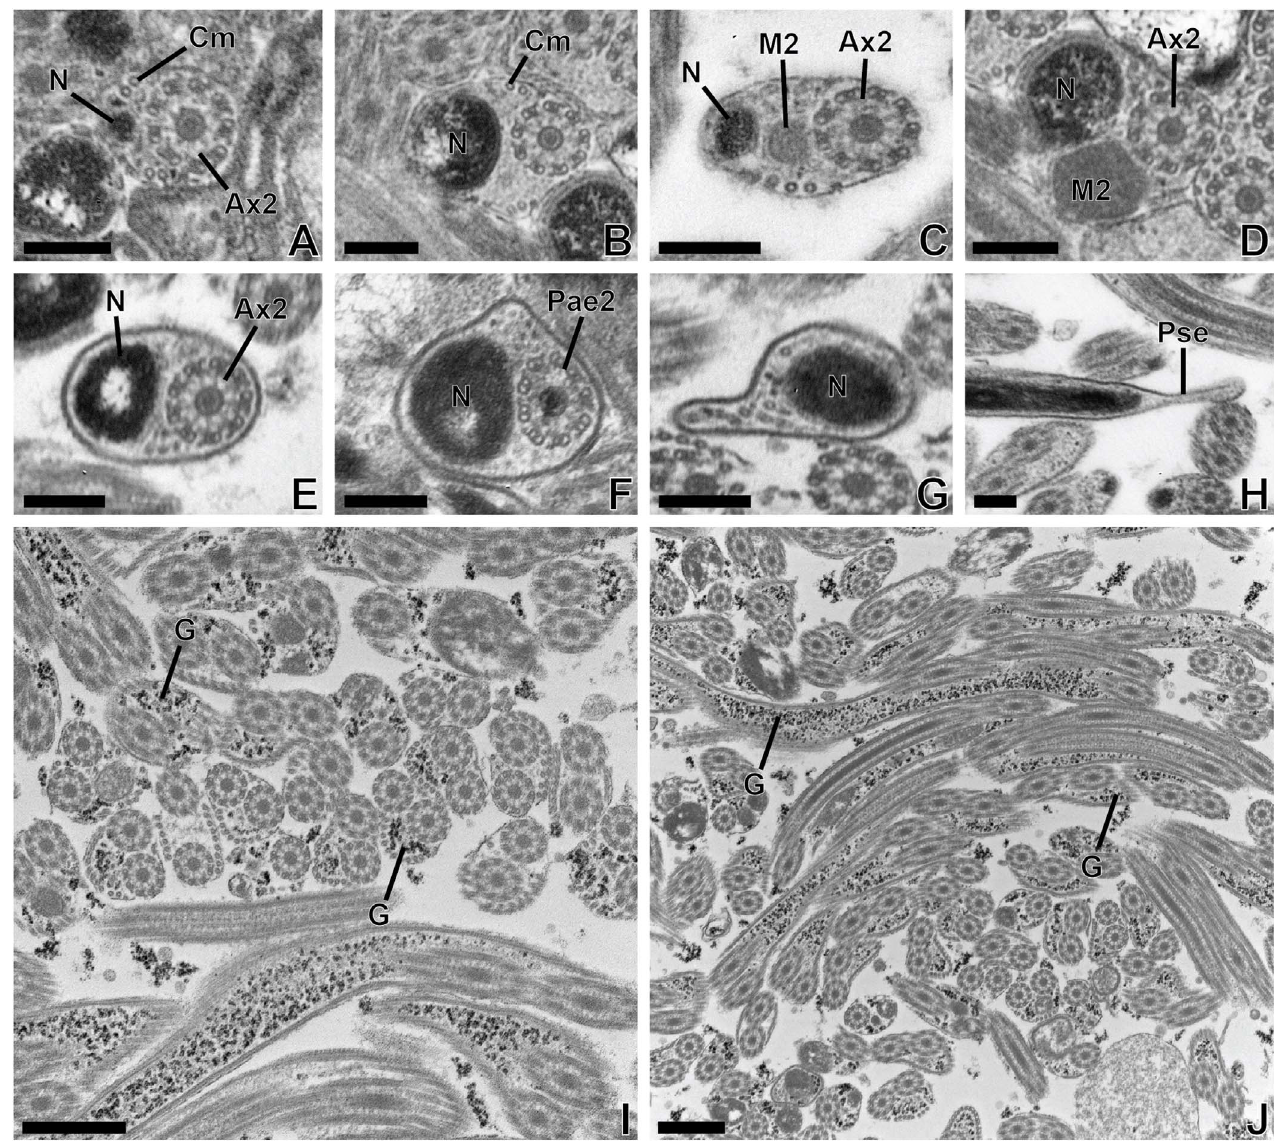
Figure 4. (A – H) Transmission electron micrographs of the posterior region (or region IV) of the mature spermatozoon of Tergestia laticollis. Scale bars = 0.2 l m. Cross-sections in region IV of mature spermatozoon of Tergestia laticollis showing the appearance of the nucleus (A – B), then the second mitochondrion (M2) (C). (D – E) Cross-sections showing progressively the disappearance fi rstly of the second mitochondrion and cortical microtubules. (F) Cross-section showing the disorganization of axoneme 2 (Pae2). (G) Cross-section in the posterior extremity of the spermatozoon exhibiting only the nucleus and a few granules of glycogen. (I – J). Transmission electron micrograph showing many sections of the mature spermatozoon of Tergestia laticollis with granules of glycogen (G) highlighted by the Thiéry method. Scale bars = 0.5 l